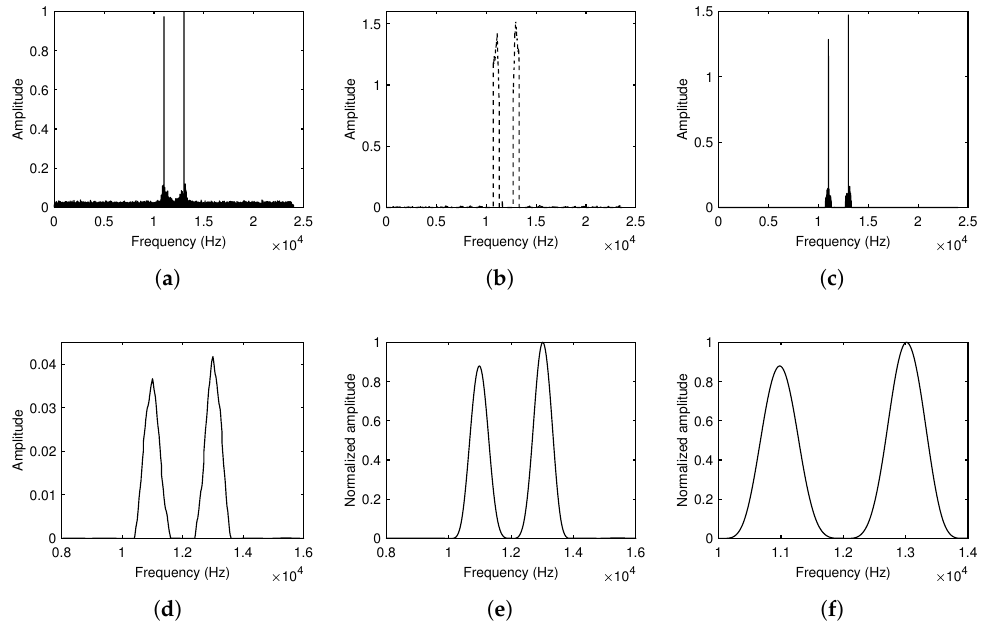
Figure 4. Waveform optimization of 2FSK. ( a ) Waveform after absolute value acquisition, ( b ) gain coefficient, ( c ) waveform after spectral peak enhancement, ( d ) partial enlargement of the waveform after moving average filtering, ( e ) partial enlargement of the waveform after Gaussian fitting, and ( f ) partial enlargement of ( e